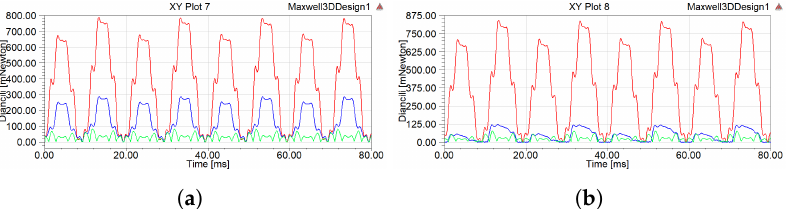
Figure 20. Dynamic response curves of electromagnetic force on each winding under working condition 2. ( a ) The left column. ( b ) The right